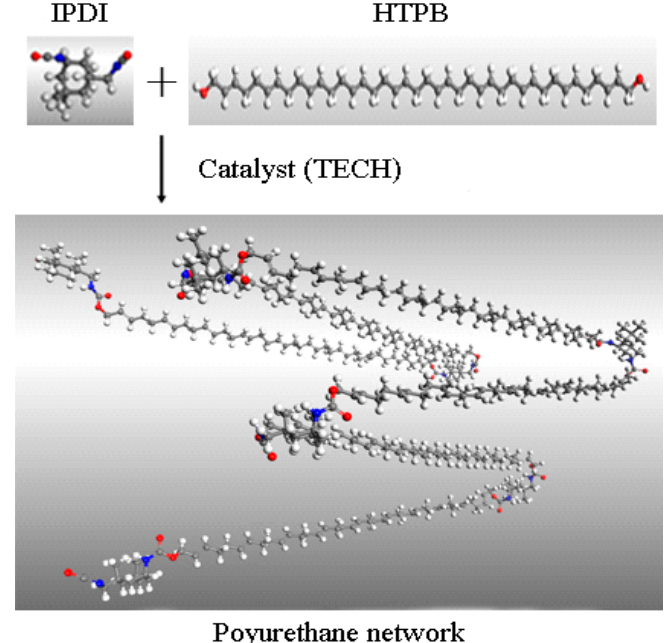
Figure 1. Schematic diagram of polyurethane network formation from HTPB and IPDI.